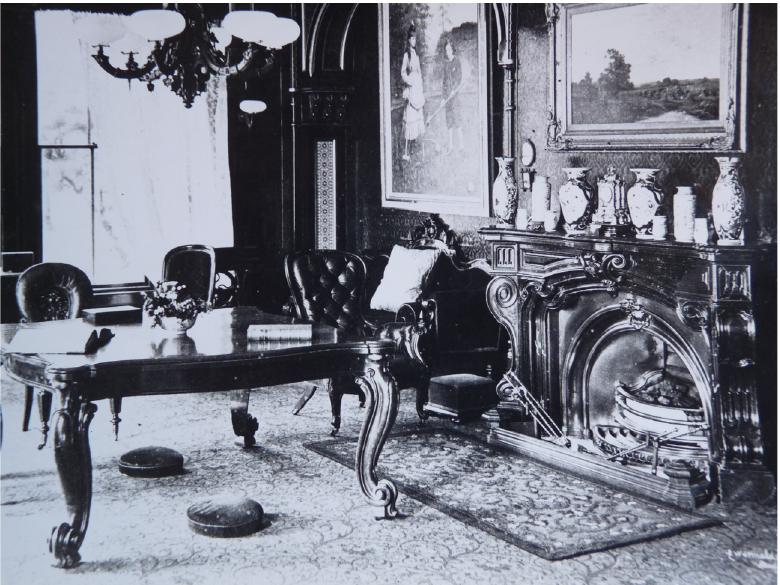
Figure 2: French-style furnishings in the dining room at Claremont, home of Dr John Heaton (Yorkshire Archaeological